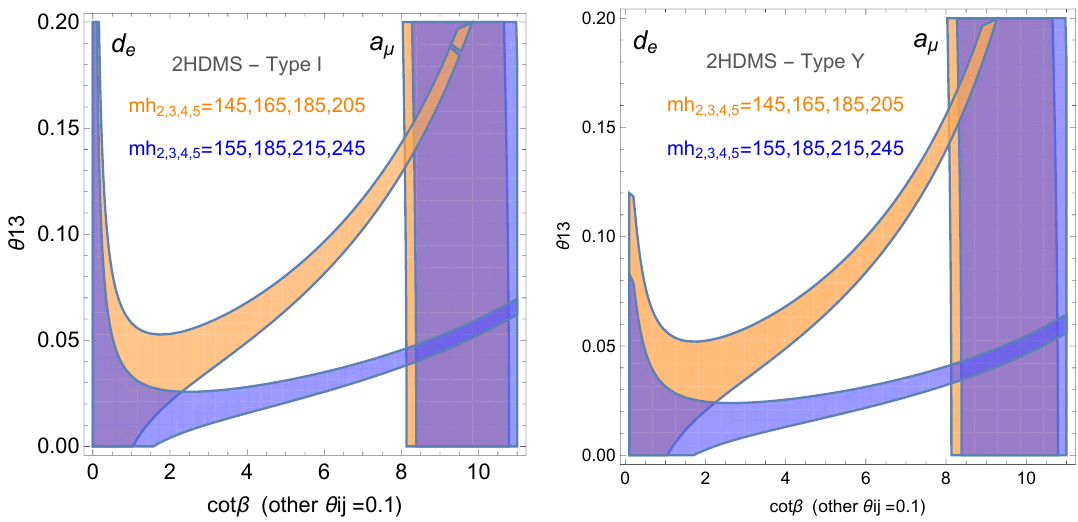
Figure 16 . Regions surviving d e bounds while producing a (cid:22) in 2HDM+CS Type-I and Y for mid- range m h masses (in GeV) and (cid:12)xed values of angles. Note that by changing m h 2 ; 3 ; 4 ; 5 it is possible to cover the whole